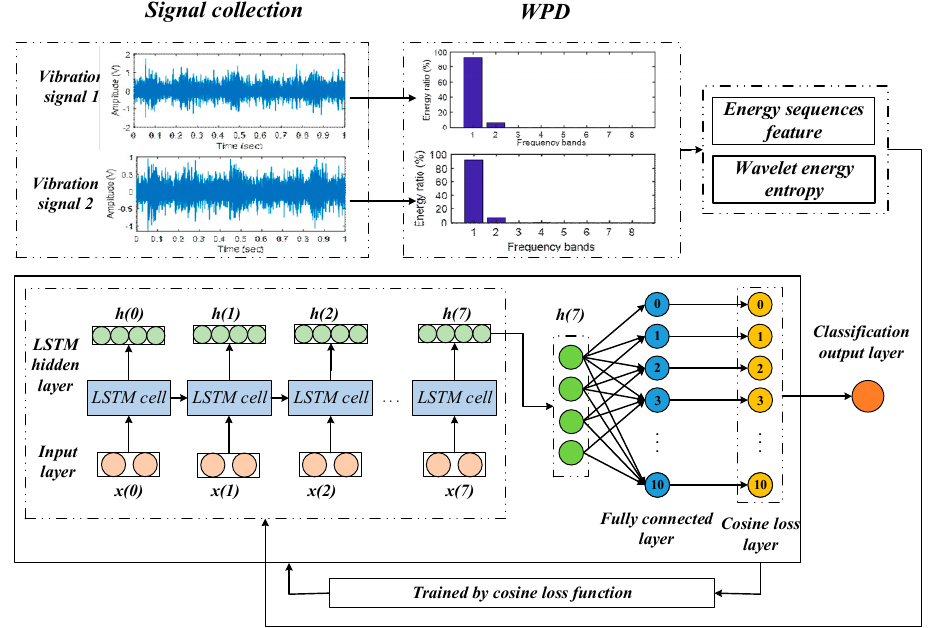
Figure 4. The flow chart of the Cos-LSTM method for gearbox fault diagnosis.